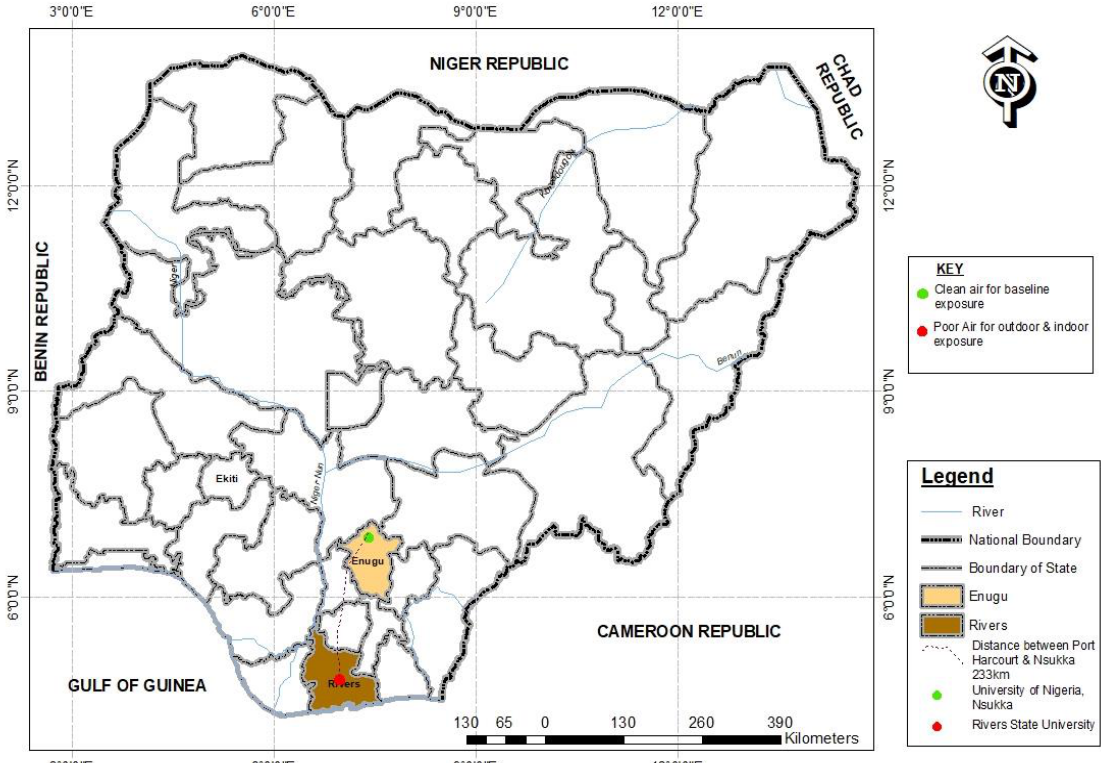
Figure 2. Study Figure 2. Study areas.